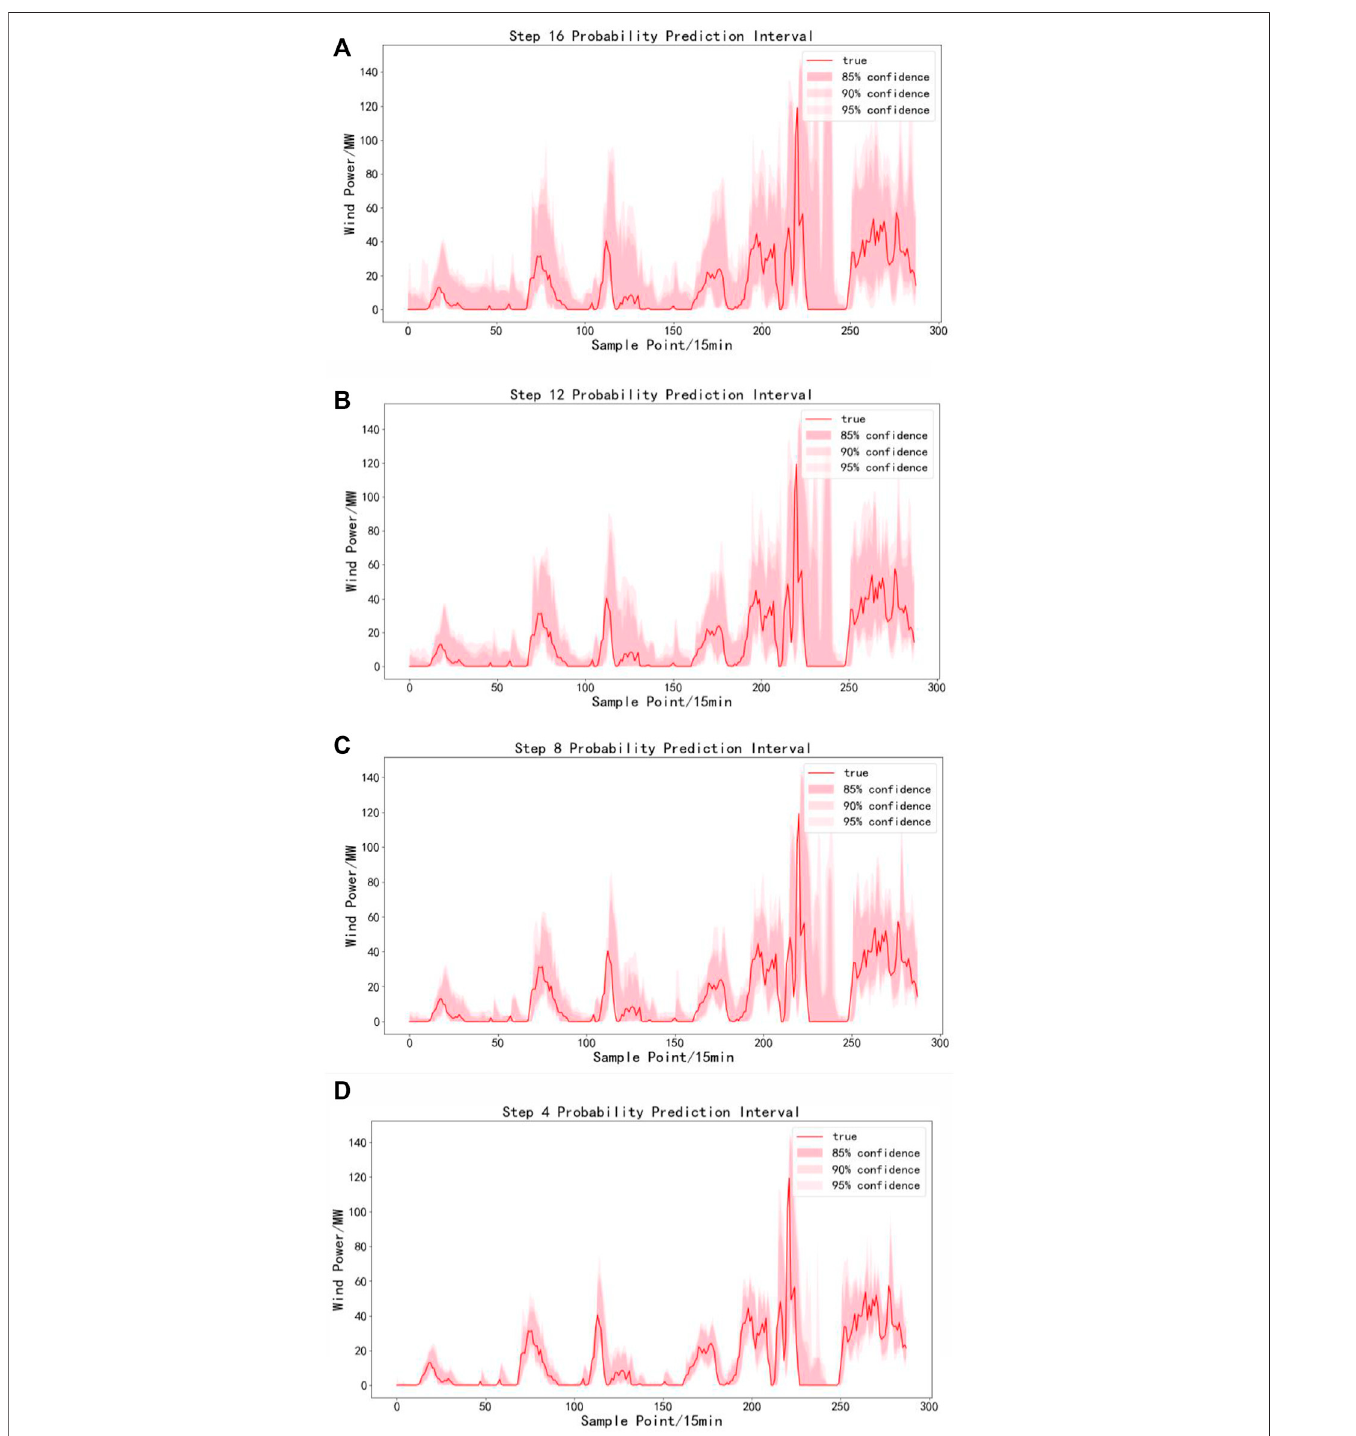
FIGURE9| Predictionintervalofproposedmodelindifferenttimescalesinspring.Thelabels (A – D) istheintervalpredictioneffectdiagramofthemethodproposed in 16 th , 12 th , 8 th , 4 th .